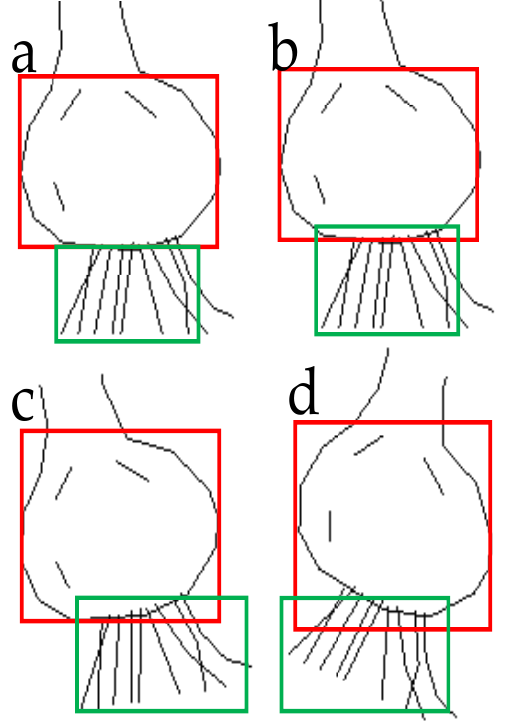
Figure 8. Location Relationship ( a ) Position l; ( b ) Position 2; ( c ) Position 3; ( d ) Position 4.